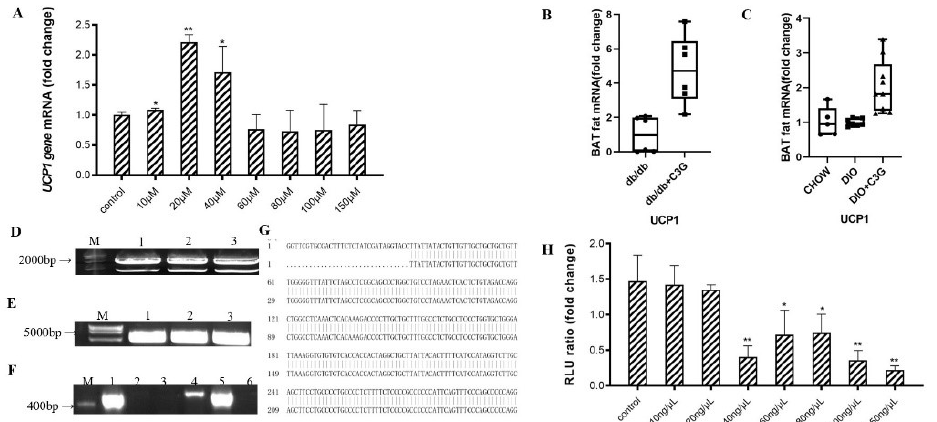
Figure 1. C3G was able to up-regulate the expression of Ucp1 gene both in vitro and in vivo. ( A ) Effects of C3G at different concentrations on Ucp1 gene expression in C 3 H 10 T 1/2 cells. ( B , C ) C3G up-regulated the expression of Ucp1 gene both in db/db mice model ( B ) and mice with DIO model ( C ) ( n = 6–8). ( D ) Electrophoretic map of cloned Ucp1, M: Kang was 200Bpladder; Lane 1–3: Ucp1 amplification products ( E ) Electrophoresis diagram of pGL3-Basic enzyme digestion product, M: DL15000 marker; Lane 1–3: pGL3-Basic double enzyme digestion product.( F ) PCR electrophoresis diagram of pGL3-Ucp1 bacterial solution; M: Kang Wei 200Bpladder; Lane 1–6: PCR products from the picked six single-colony bacterial solutions.( G ) Comparative diagram of sequencing results of PGL3-Ucp1 ( H ) Activation of Ucp1 promoter by C3G with different concentrations. Values represent means ± SD. Error bars represent SD; mean values with asterisk or different letters are significantly different ( p < 0.05).